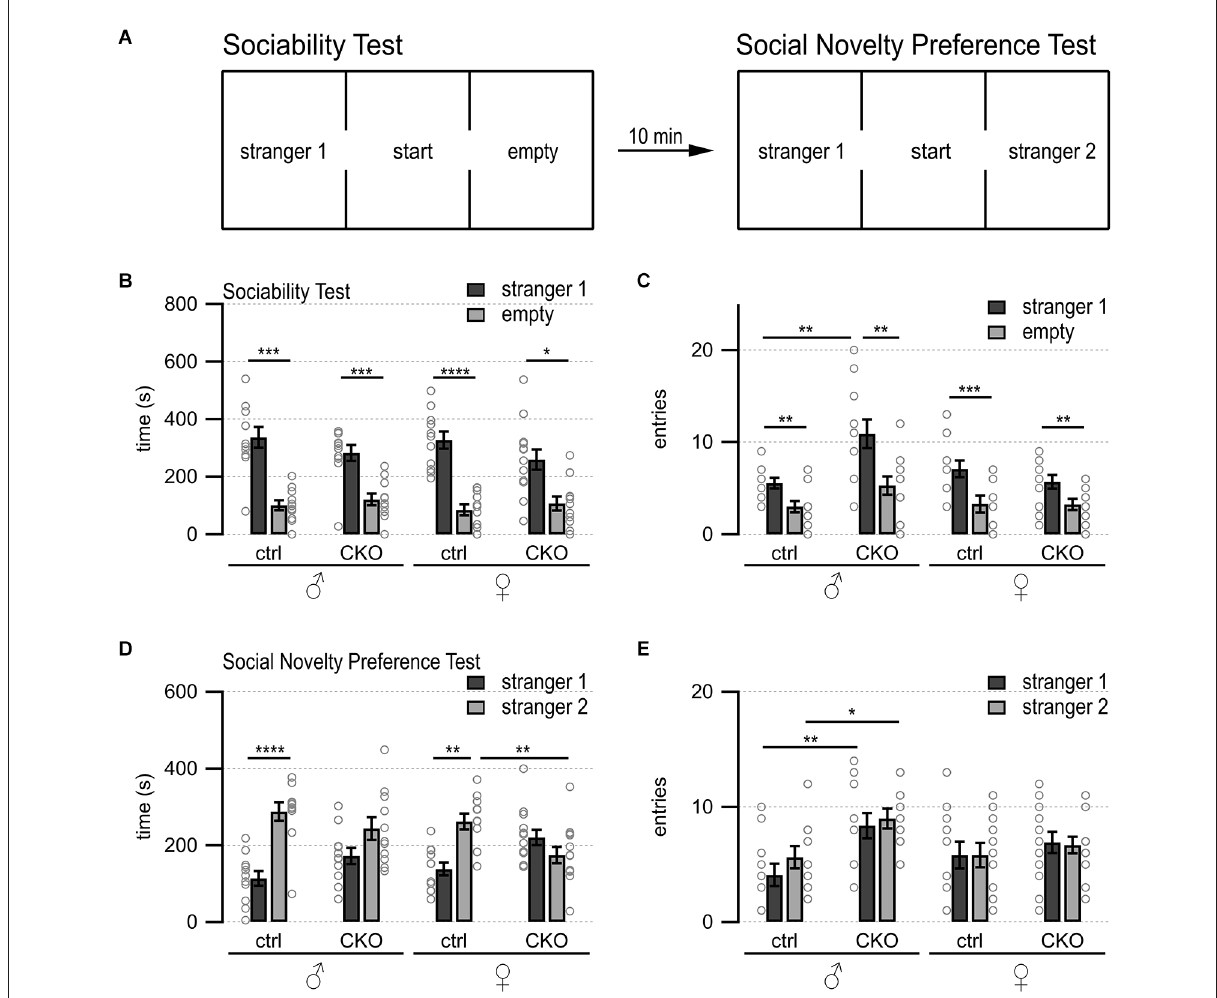
FIGURE1 Loss of GABA co-transmission from ACh neurons results in loss of social novelty preference independent of sex as well as increased chamber entries in males. Loss of GABA co-transmission leads to a loss of social novelty preference in mice as well as increased chamber entries in males but does not affect sociability. (A) Schematic showing setup of sociability and social novelty preference test. Mice habituated for 10 min in the cage with both side chambers empty. Before the sociability test, an unfamiliar sex-matched mouse (stranger 1) was introduced into the left chamber. After 10 min of the sociability test, before the start of the social novelty preference test, an unfamiliar sex-matched mouse (stranger 2) was introduced into the right chamber. Time spent in outer chambers and chamber entries were measured. (B,C) Sociability test results. Time spent in (B) and entries (C) into side chambers shown for male, female control (ctrl), and CKO mice. (D,E) Social novelty test results. Time spent in (D) and entries (E) into side chambers shown for male, female control (ctrl), and CKO mice. Values represent mean ± SEM. Individual data points are depicted as open circles. Repeated measures ANOVA followed by Fisher’s protected least-significant difference tests (* p < 0.05, ** p < 0.01, *** p < 0.001, **** p < 0.0001). See Supplementary Table 2 for